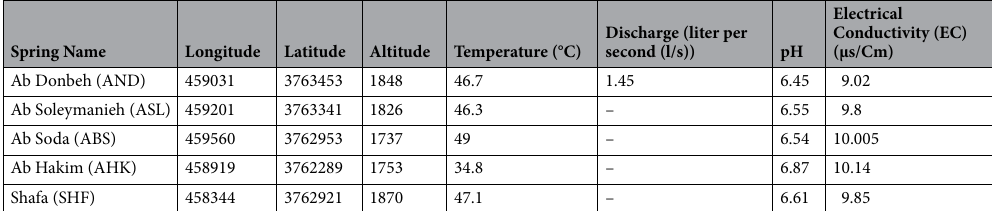
Table 1. General characteristics of warm springs in Mahallat Region. Temperature, discharge and electrical conductivity data are reported in degrees Celsius (°C), liter per second (l/s) and microSiemens per centimeter (µs/Cm), respectively.